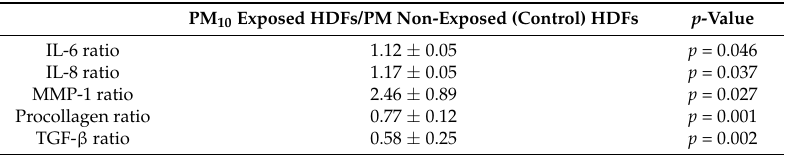
Table 1. Effect of PM 10 on the protein expression of pro-inflammatory cytokines and collagen metabolism in HDFs. ELISA results obtained from PM exposed fibroblasts and their control fibroblasts are expressed in relative ratios (fold change). The significant of the values were identified using the one-sample t -test. p -values < 0.05 were considered statistically significant. Statistical analysis of data was performed using SPSS for Windows software (version 15.0; SPSS Inc., Chicago, IL, USA). PM 10 Exposed HDFs/PM Non-Exposed (Control) HDFs p -Value IL-6 ratio 1.12 ± 0.05 p = 0.046 IL-8 ratio 1.17 ± 0.05 p = 0.037 MMP-1 ratio 2.46 ± 0.89 0.77 ± 0.12 p = 0.001 TGF- β ratio 0.58 ± 0.25 p = 0.002